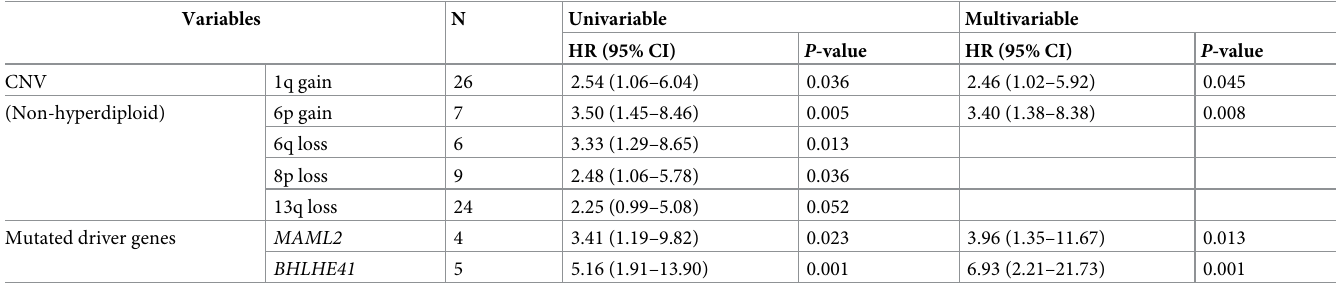
Table 3. Cox proportional hazards model for factors associated with overall survival.